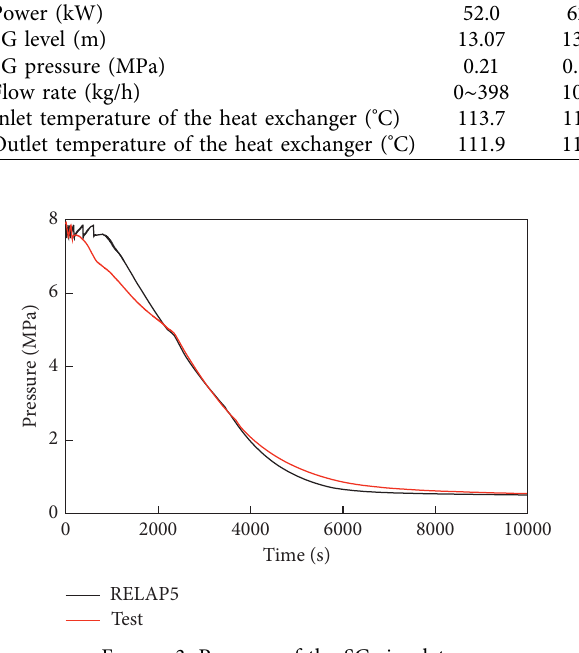
Figure 3: Pressure of the SG